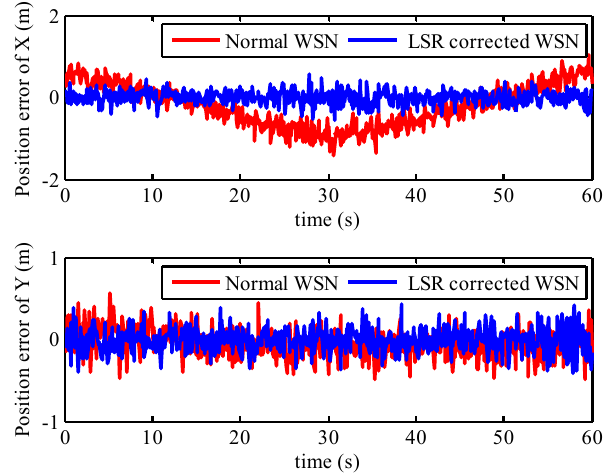
Figure 11. Position error of WSN with LSR correction model.